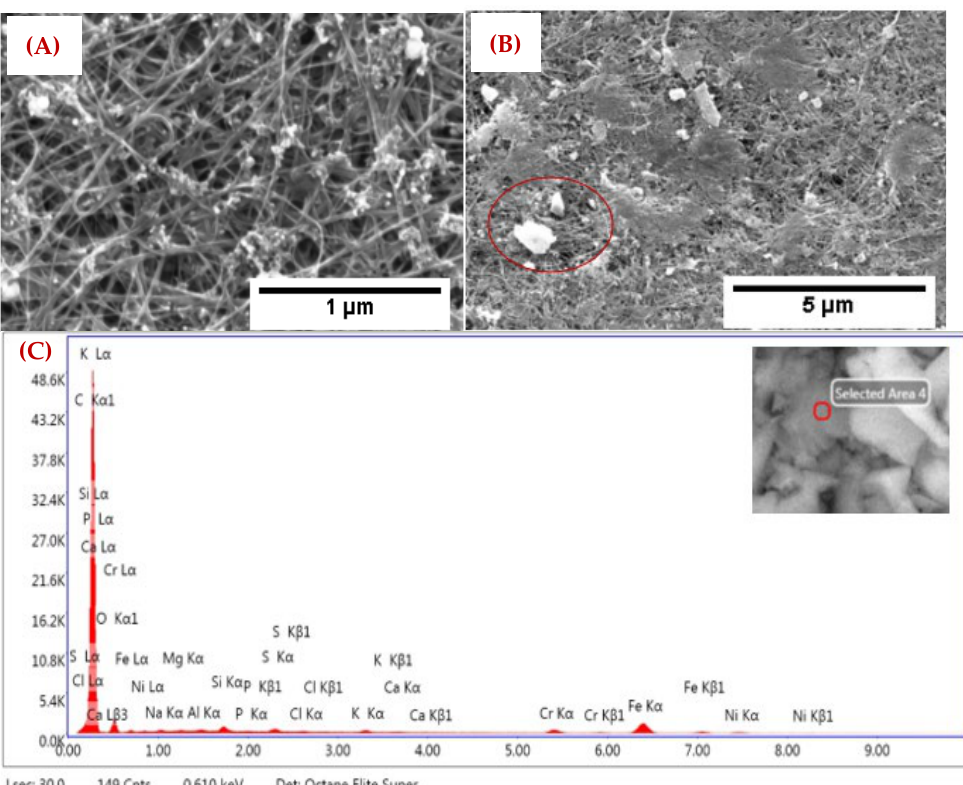
Figure 4. The CNT-GAC filtering layer; ( A ) an SEM image of captured PM at 1 µ m, ( B ) at 5 µ m, and ( C ) the EDX spectrum of captured